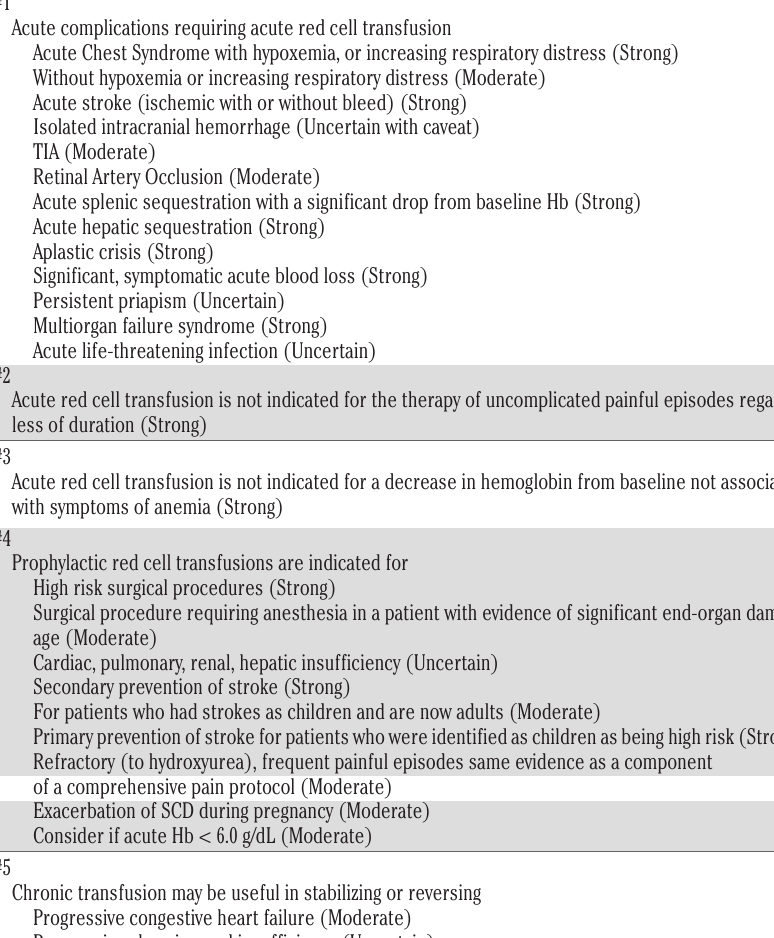
Table 3. Recommendations. #1 Acute complications requiring acute red cell